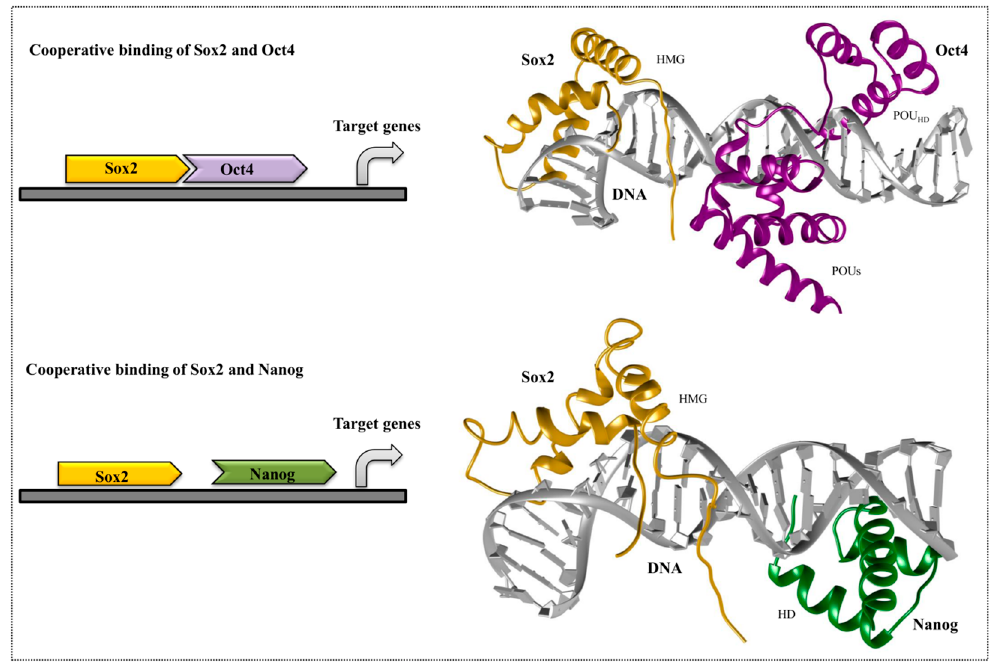
Figure 4. Representative figure of the cooperative binding of stem cell factors. The figure illustrates the cooperative binding of Sox2 and Oct4, as well as Sox2 and Nanog, on their enhancers/promoters of target genes. The Oct4/Sox2 crystal structure is obtained from PDB (1gt0), whereas Sox2/Nanog structure was modeled using chimera.